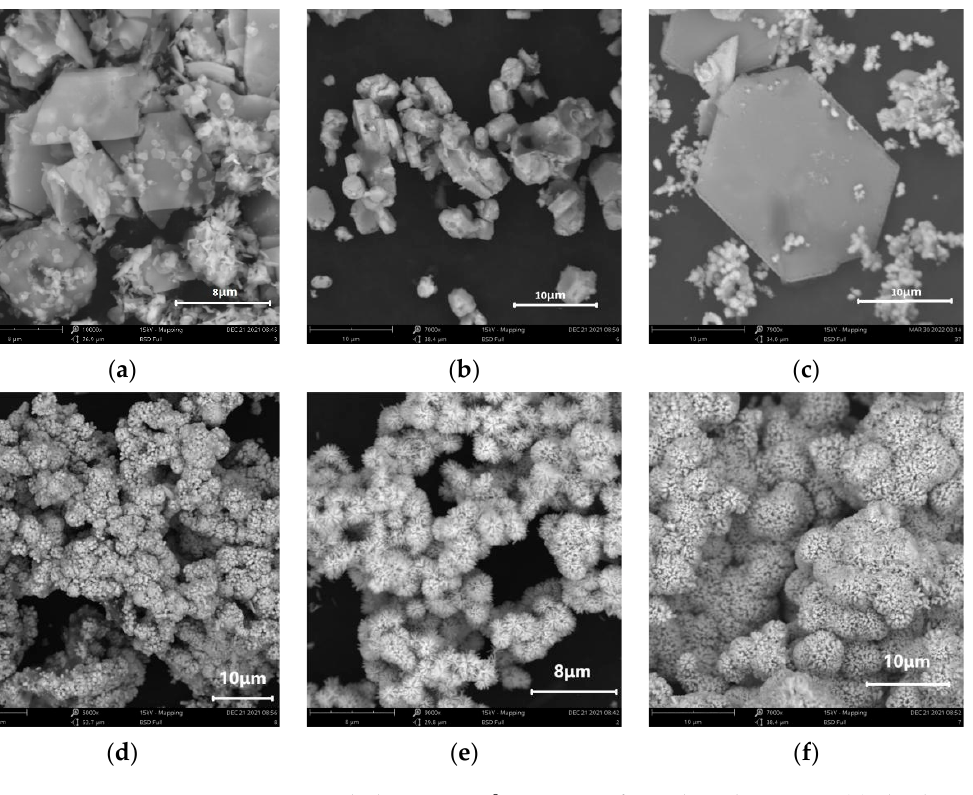
Figure 2. SnO 2 morphology at 200 °C, reacting for 48 h without PVP: ( a ) absolute alcohol: 80 mL; ( b ) ratio of absolute alcohol to denoised water (V) = 3:1; ( c ) V = 5:3; ( d ) V = 9:7; ( e ) V = 1:1; ( f ) V = 3:5.